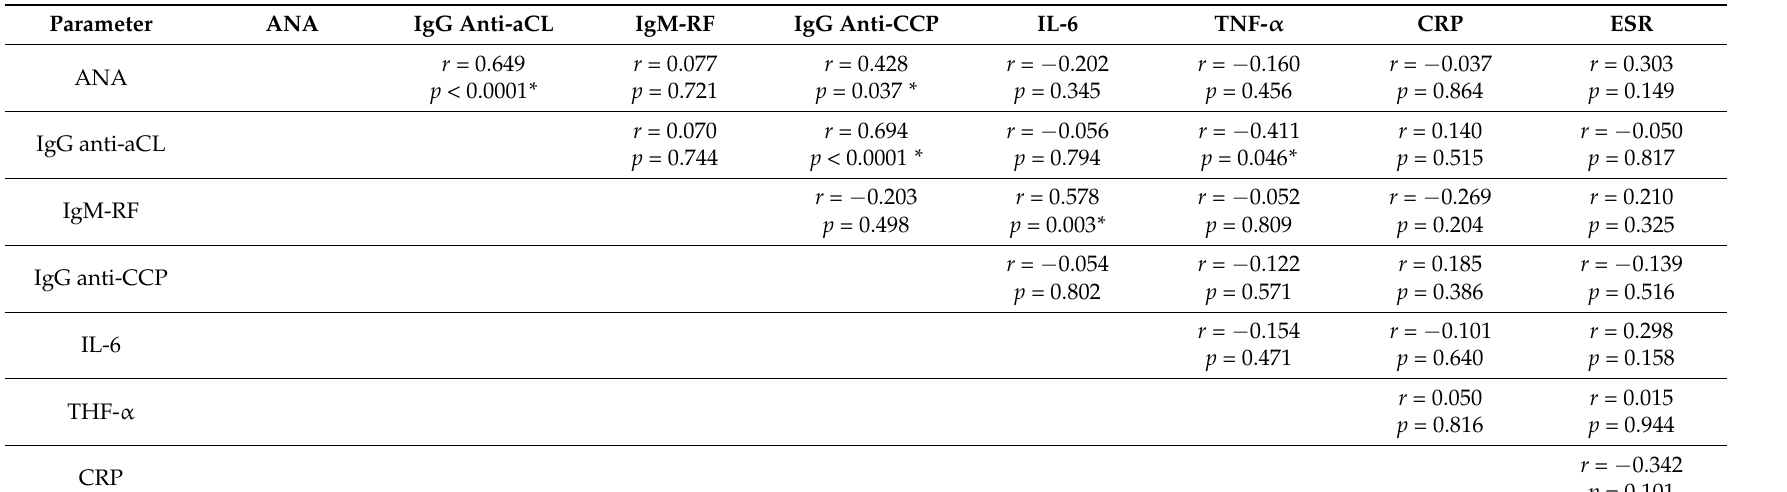
Table 4. Correlations between IL-6, THF- α and hepatitis C virus-related arthropathy (HCVrA)